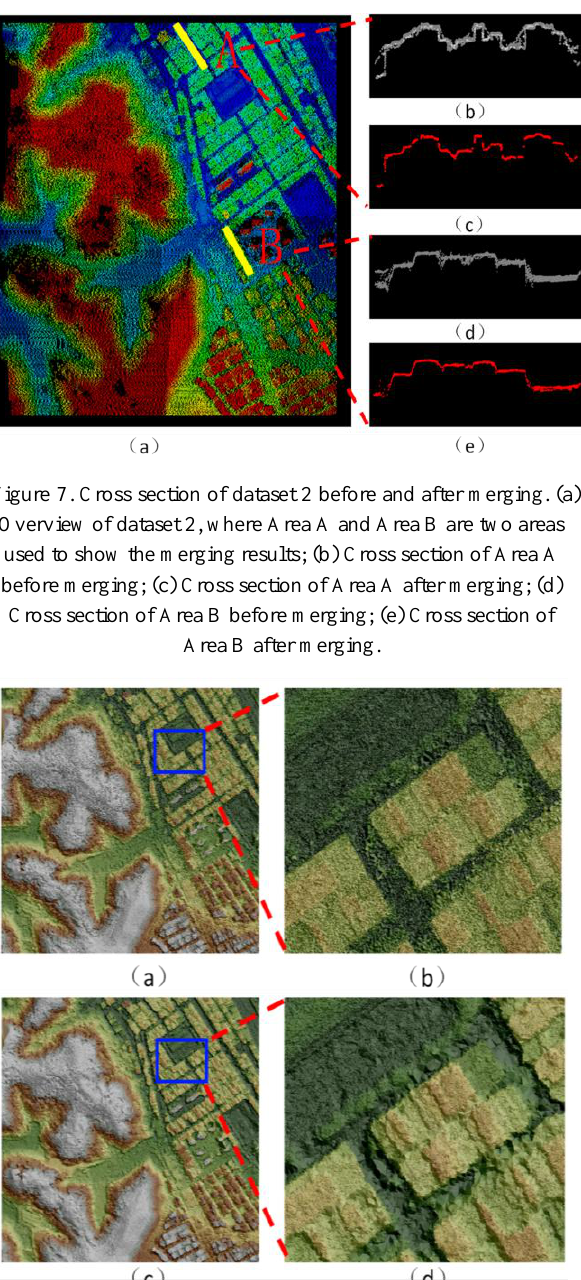
Figure 8. Triangulation of dataset 2 before and after merging. (a) Triangulation of dataset 2 before merging; (b) Enlarged subsets of dataset 2 before merging; (c) Triangulation of dataset 2 after merging; (d) Enlarged subsets of dataset 2 after merging.